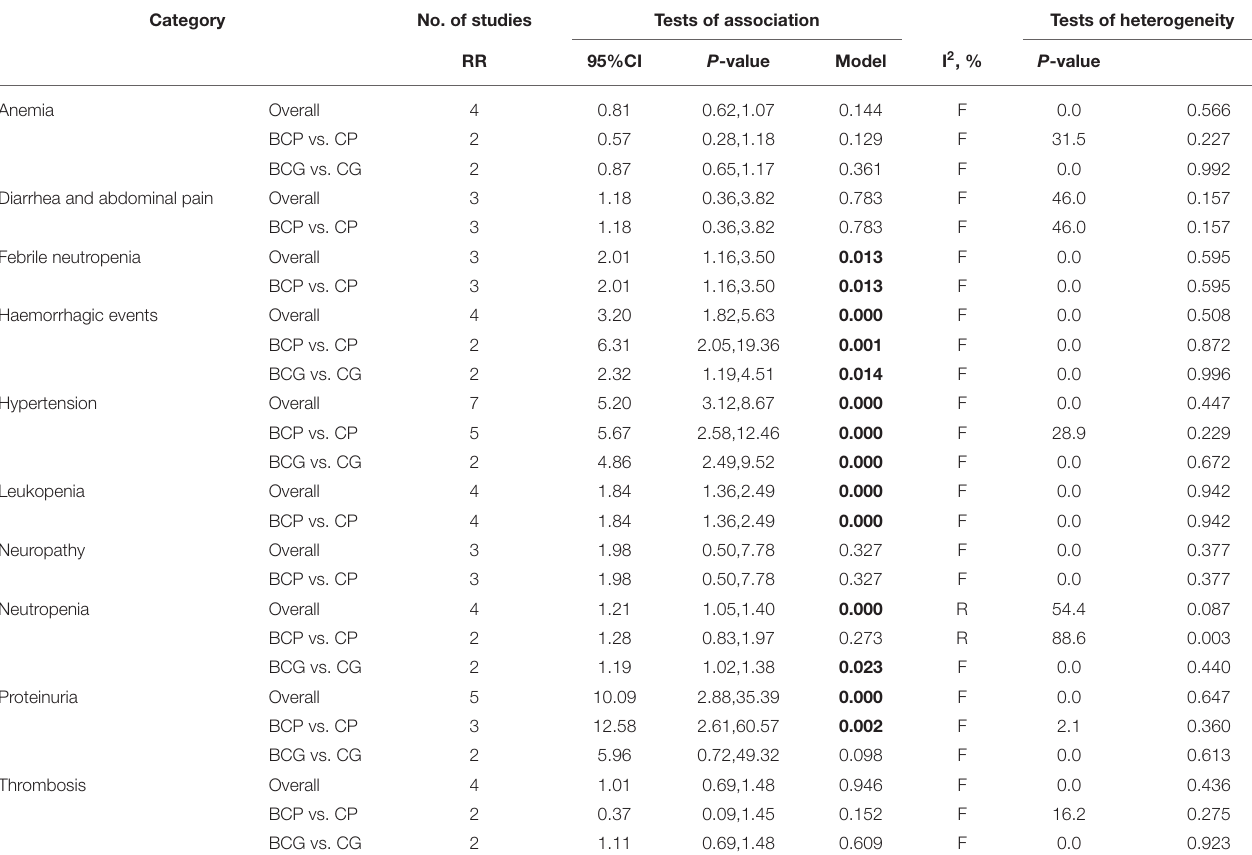
TABLE 2 | Subgroup analyses of AEs based on treatment.